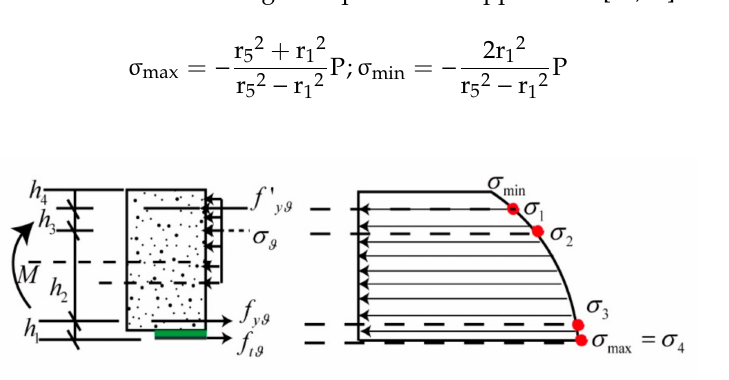
Figure 16. Tangential stress